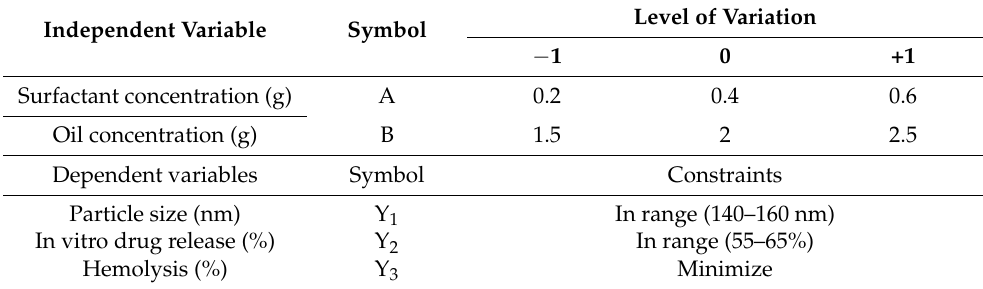
Table 4. Objectives of the optimization process.